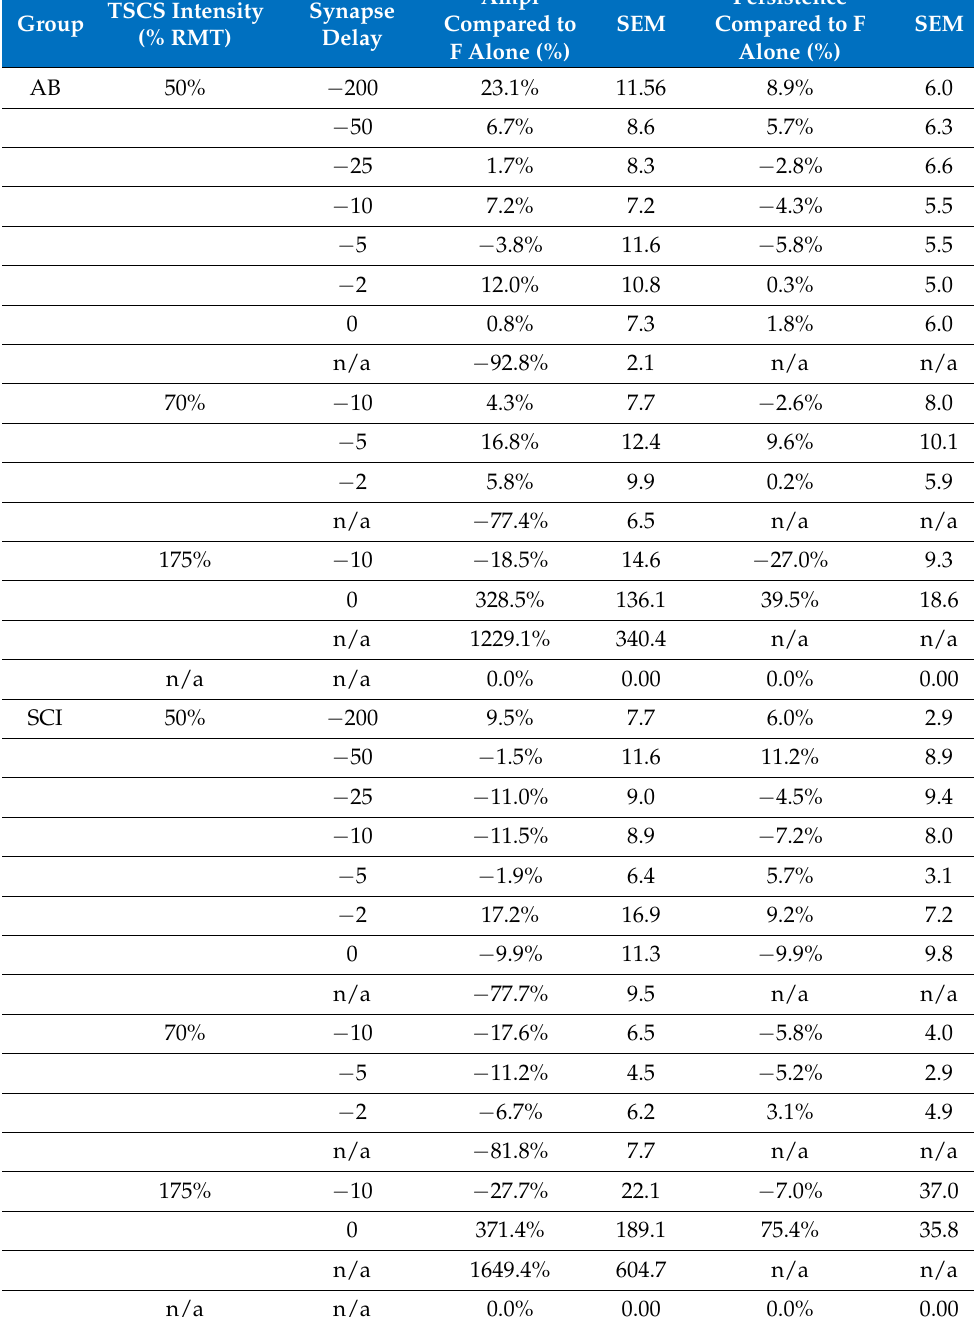
Table 5. F-wave responses to conditioning TSCS